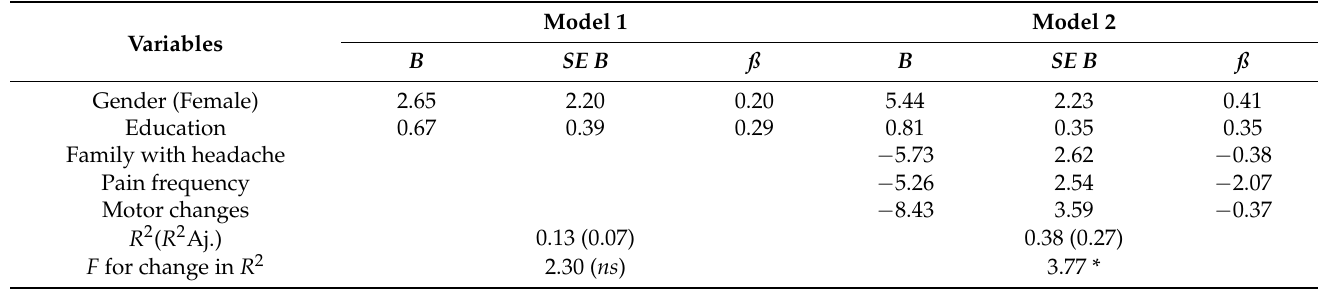
Table 6. Variables that contribute to pain acceptance in the TMD-headache group.